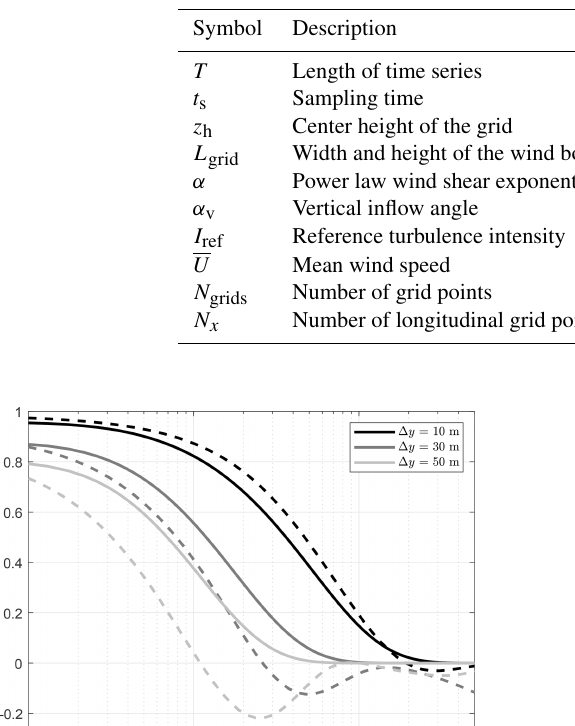
Table 1. Settings for generating the turbulence box.